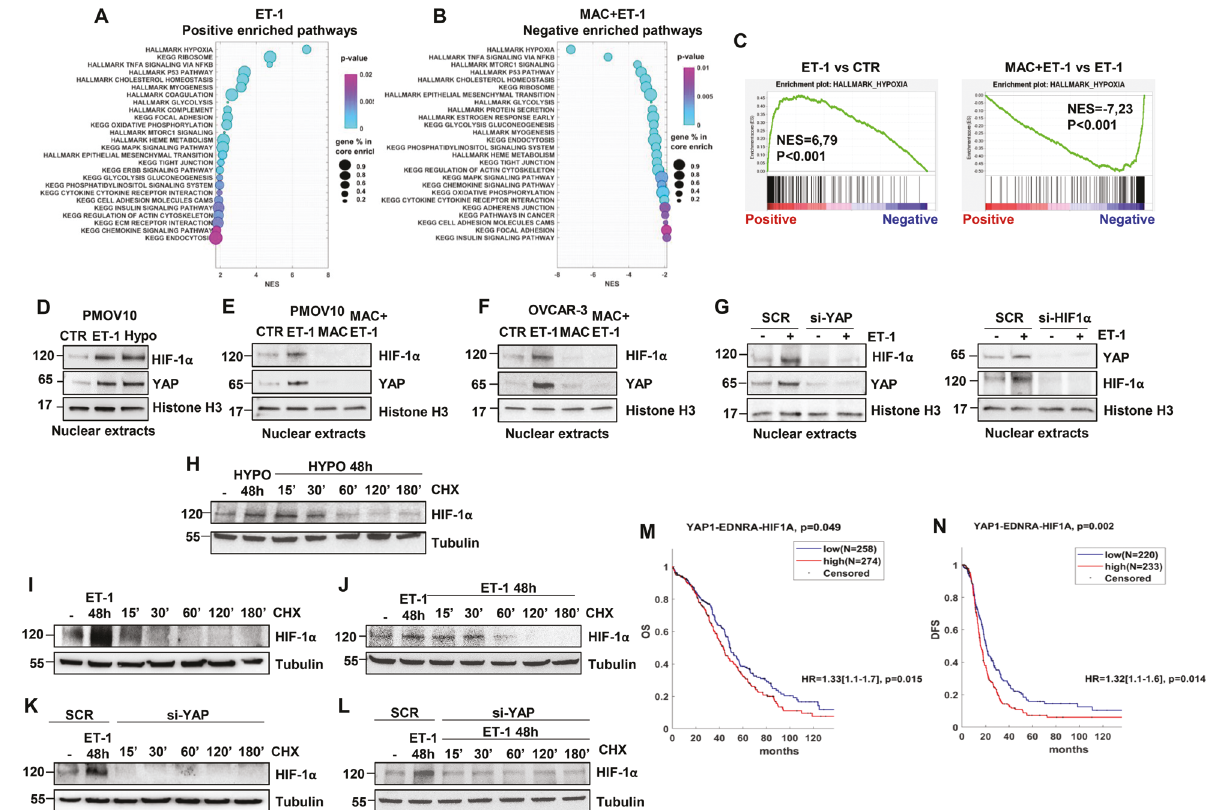
Fig. 1 ET-1 drives HIF-1 α and YAP nuclear accumulation, and the YAP1/EDNRA/HIF1A signature is correlated with poor prognosis in HG- SOC patients. A , B Bubble charts of the top 26 hallmark and KEGG gene sets enriched in HG-SOC patient-derived (PD) primary cultures of HG- SOC cells (PMOV10) upon ET-1 (100 nM) stimulation for 24 h in comparison to untreated cells (CTR) ( A ) or downregulated upon macitentan (MAC, 1 µM) plus ET-1 treatment for 24 h in comparison to ET-1-treated cells ( B ). C ET-1 enriches the hypoxia gene signature in PMOV10 cells. GSEA in cells stimulated with ET-1 or treated with MAC plus ET-1 with the normalized enrichment score (NES). D – F Immunoblotting (IB) analysis for HIF-1 α and YAP in nuclear extracts of PMOV10 ( D , E ) and OVCAR-3 ( F ) cells stimulated with ET-1 for 2 h ( D – F ) or treated with MAC ( E , F ). Histone H3 represents the loading control. G IB analyses of HIF-1 α and YAP protein expression in nuclear extracts of PMOV10 cells stimulated with ET-1 for 2 h and transfected for 72 h with a siRNA control (SCR) or siRNA speci fi c for YAP (si-YAP; left ) or HIF-1 α (si-HIF-1 α , right ). H - J PMOV10 cell extracts stimulated with ET-1 ( I , J ) or hypoxia ( H ) for 48 h were treated with cycloheximide (CHX: 100 µM) for the indicated times. Tubulin represents the loading control. K , L PMOV10 cell extracts silenced for YAP and stimulated ( L ) or not stimulated ( K ) with ET-1 for 48 h were treated with CHX for the indicated times. Tubulin represents the loading control. Representative images of blots of 3 independent experiments are shown in D-L. M , N Overall survival (OS) and disease-free survival (DFS) analysis of HG-SOC patients with high and low combined gene expression levels of YAP1 , EDNRA and HIF1A (OS ( M ): p = 0.049; DFS ( N) : p = 0.002). The combined expression was obtained considering the average values of the genes. High and low expression were then evaluated in consideration of positive and negative z scores, respectively. Differences between curves were assessed by the log-rank test. A Cox hazard regression model was also included with hazard risk (HR), con fi dence interval at 95% and a p value as an estimate of the signi fi cance of this interval. A p value less than 0.05 (<0.05) was considered signi fi cant (OS HR: p = 0.015; DFS HR: p =